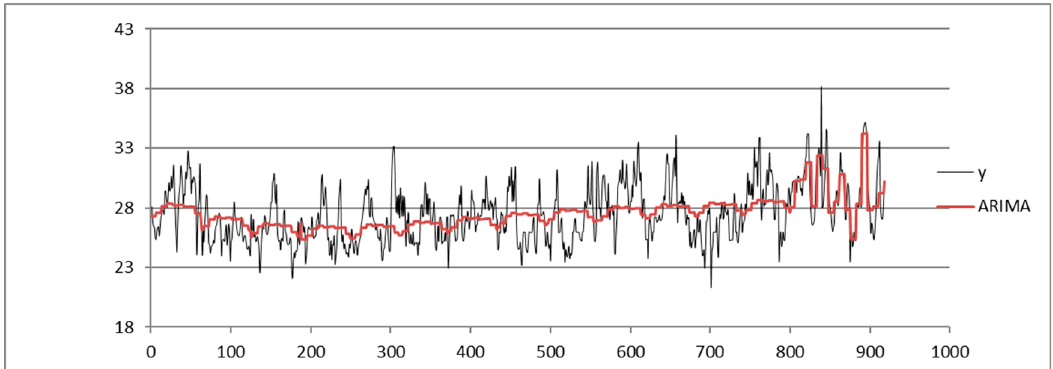
Figure 3. Plot of HI index time series from the Napoli Capodichino station dataset obtained by using the Seasonal Autoregressive Integrated Moving Average (ARIMA) algorithm.